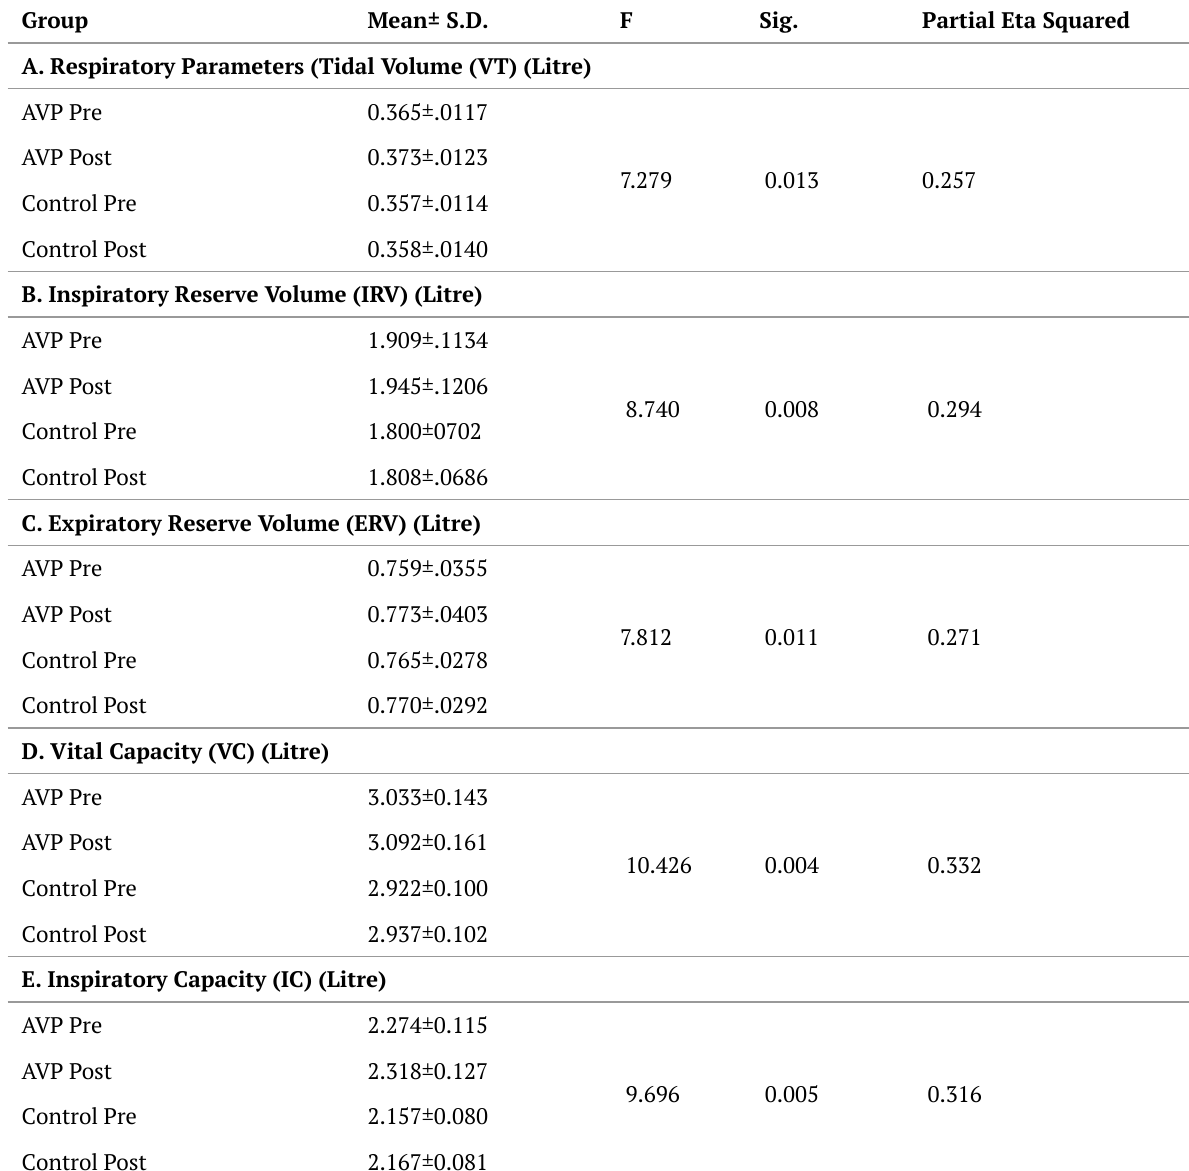
Table 4. Analysis of Covariance (ANCOVA) between Group A (AVP) and Group C (control) on respiratory